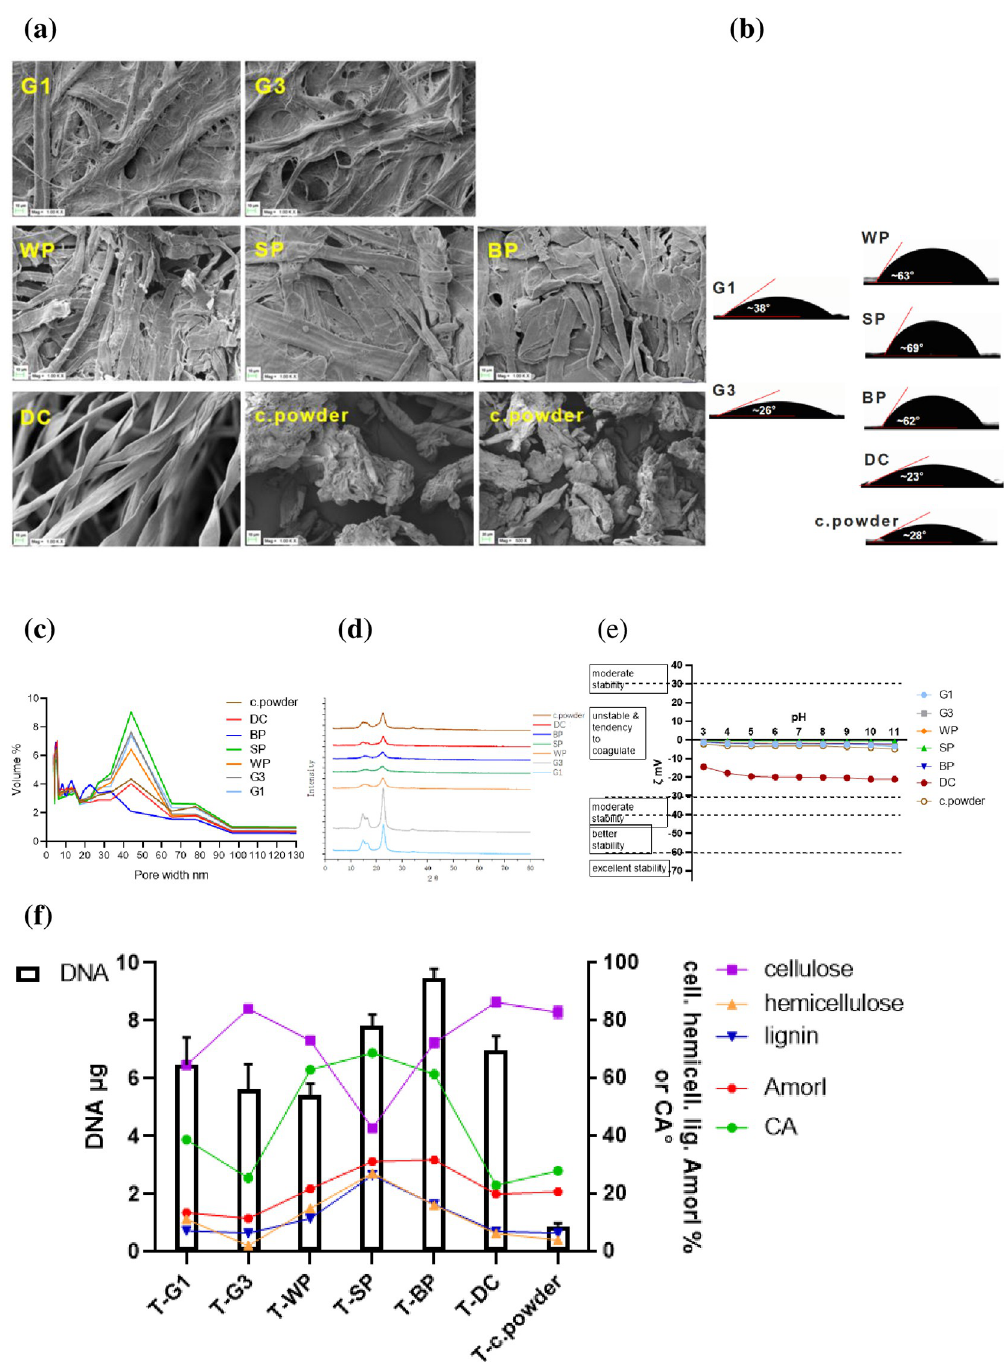
Fig 5. (a) Images of related PF-BAs under a scanning electron microscope (SEM) (x1000). (b) Contact angle of related PF-BAs. (c) Distribution of pore size in the selected PF-BAs using BJH model. (d) Crystallinity of related PF-BAs assessed via XRD analysis. (e) Zeta point (pH 3–11) of related PF-BAs (c.powder refers to cellulose powder). (f) Comprehensive histogram and line chart visualizing the relationship among the quantities of extracted DNA, cellulose, hemicellulose, lignin, AmorI and CA in the selected